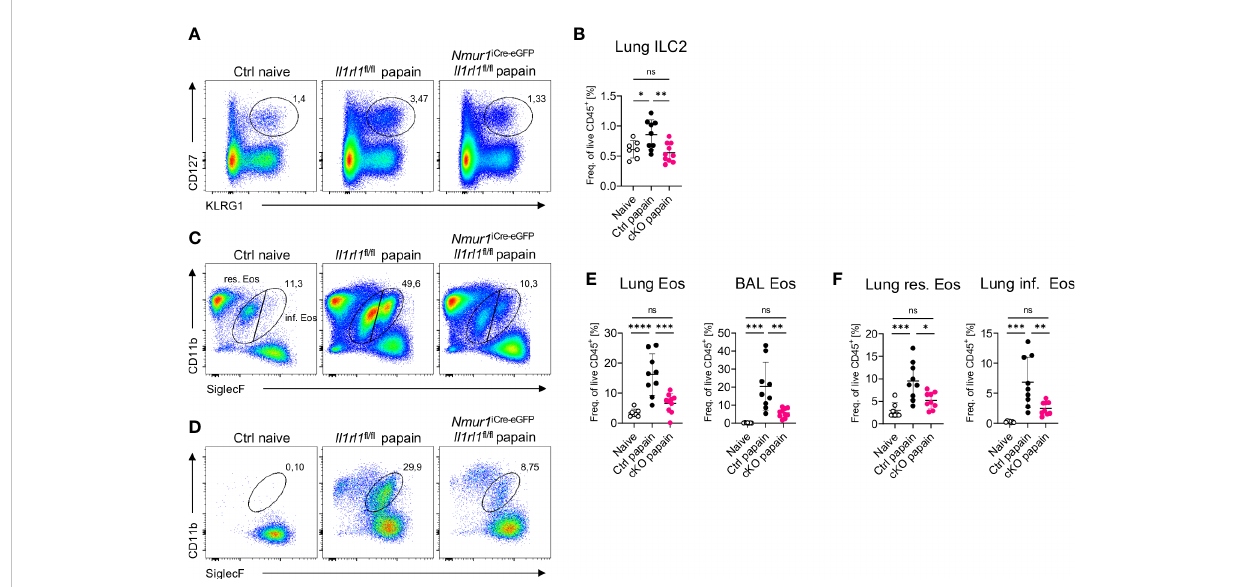
FIGURE 5 ST2-de fi cient ILC2s fail to recruit eosinophils in acute lung in fl ammation. (A, C, D), Flow-cytometric plots showing ILC2s (A) in the Lung, eosinophils (C) in the lung or BAL (D) of untreated Ctrl (naïve) animals and papain treated Nmur1 iCre-eGFP Il1rl1 fl ox/ fl ox mice (cKO) and littermate controls (Ctrl). Data are representative of two experiments with four to six mice per group. (B, E) , Quanti fi cation of relative ILC2 (B) and eosinophil numbers from the lung or BAL (E) in the lung and BAL. (F) , Quanti fi cation of relative resident and in fl ammatory eosinophil numbers in the lung. For (B, E, F) : One- way ANOVA with multiple comparisons, ns, not signi fi cant, *p < 0.05, **p < 0.01, ***p < 0.001, ****p <